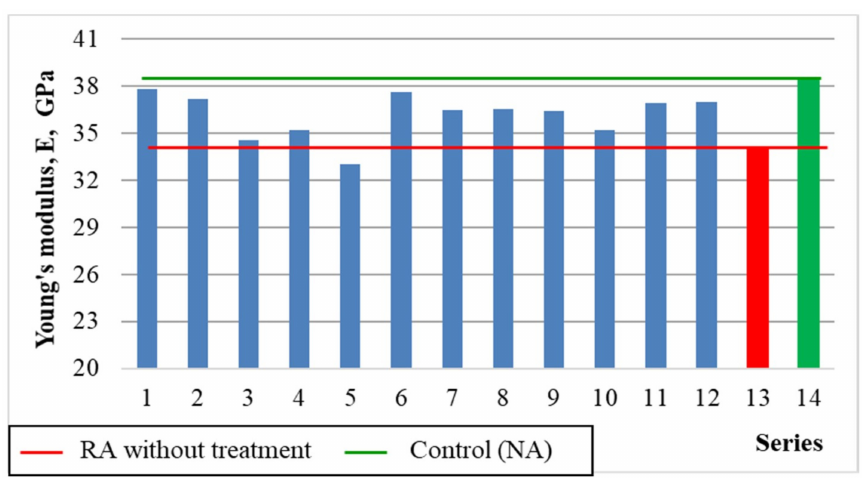
Figure 8. Young’s Modulus of concretes compared with series 13 and 14.